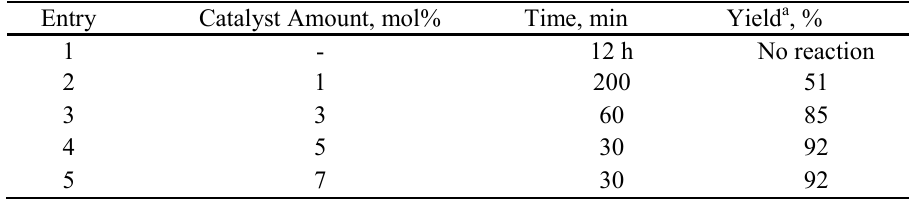
Table 1. The reaction of acetophenone with benzaldehyde, acetonitrile and acetyl chloride using different molar ratios of MTSA at room temperature.